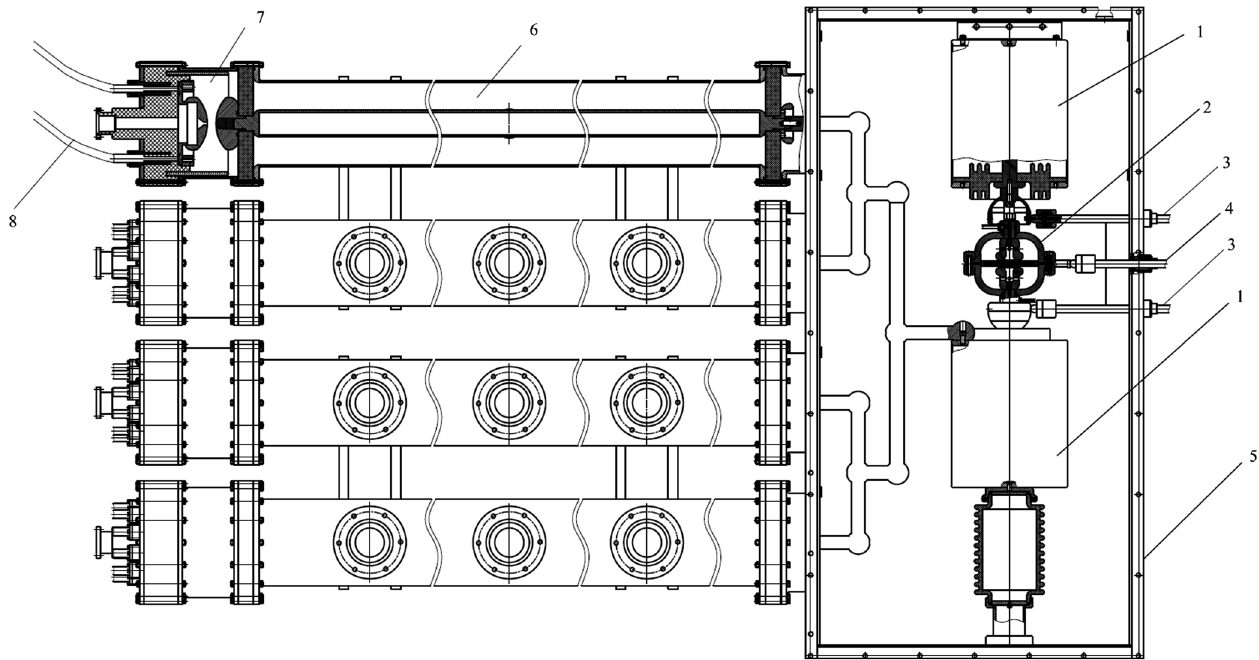
FIG. 13. Layout of a trigger unit, which includes a mini-Marx generator (5), four pulse forming lines (6), four laser triggered gas switches (7), and forty output cables (8). In the mini-Marx, there are two capacitors (1), an electrically triggered gas switch (2). The cables (3) are connected to positive/negative chargers, and cable (4) is connected to trigger.